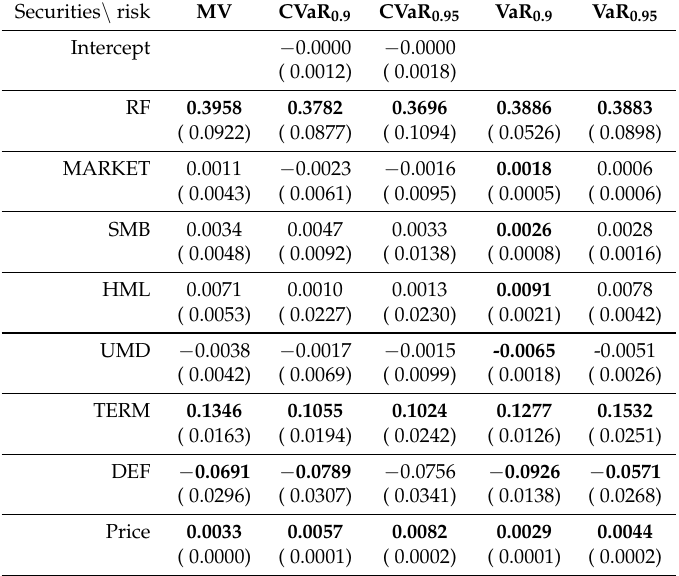
Table 3. Hedging of Term Spread. The table reports the estimates and their corresponding bootstrap errors (based on 400 bootstrap replications) for different risk measures (mean-variance MV, conditional value-at-risk CVaR, and value-at-risk VaR). The bold font represents statistical significance (at the 5% nominal level) of individual coefficients except for the last row where the bold font signifies a statistically different price from E ( y ) .